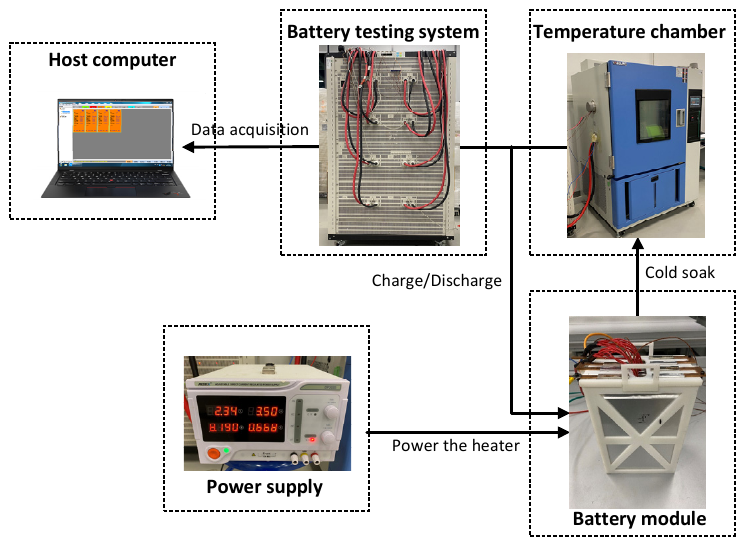
Figure 10. Experimental platform of ba tt ery external heating